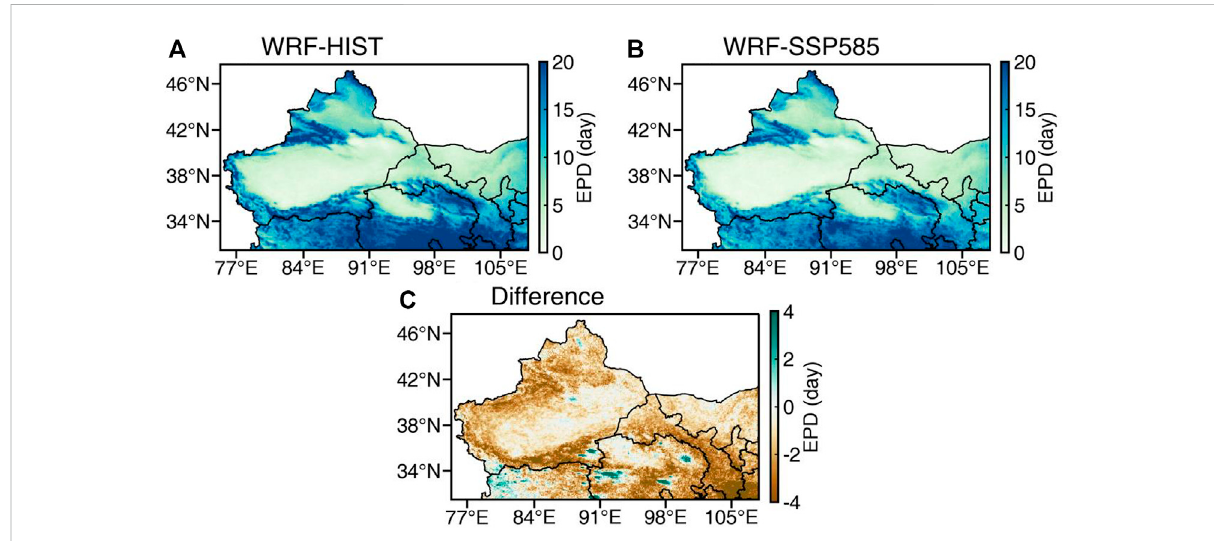
Supplementary Figure S1. While the WRF model tends to slightly overestimate precipitation over western NW, the spatial pattern of precipitation simulated by WRF-HIST generally agrees well with ground meteorological observations, which implies the strong capability of the WRF model due to robust physical parameterization schemes in WRF con fi